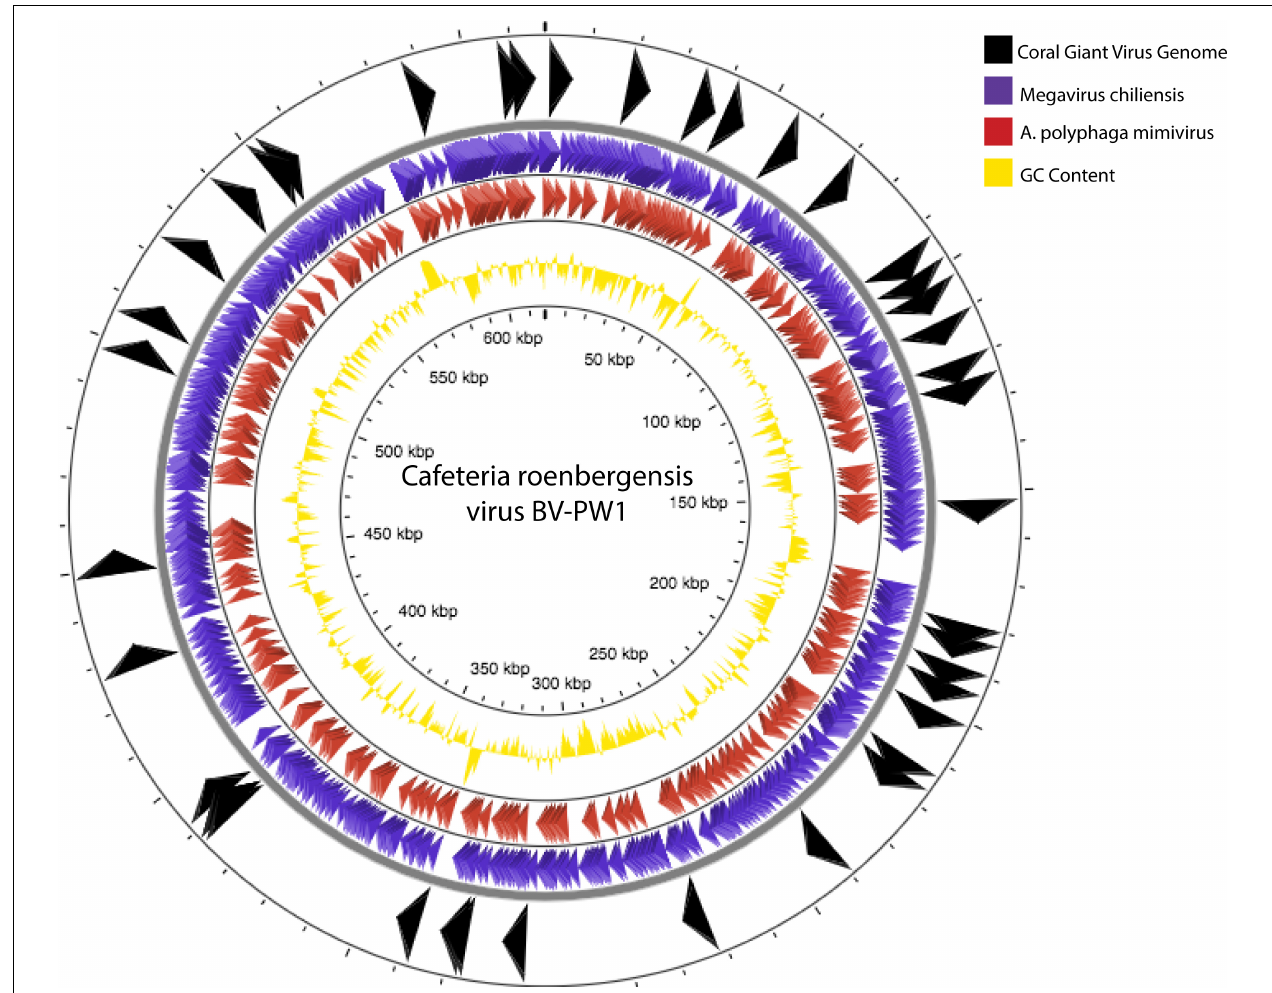
FIGURE 6 | Genome comparisons of our assembly to Cafeteria roenbergensis virus (CroV) BV-PW1 (length: 617,453 bp). Arrows indicate BLAST similarities between CroV and our assembled coral giant virus genome (black arrows, outermost track), A. polyphaga mimivirus (purple arrows, second outermost track) and Megavirus chiliensis (red arrows, third outermost track). GC content of CroV is indicated by track with yellow peaks (fourth